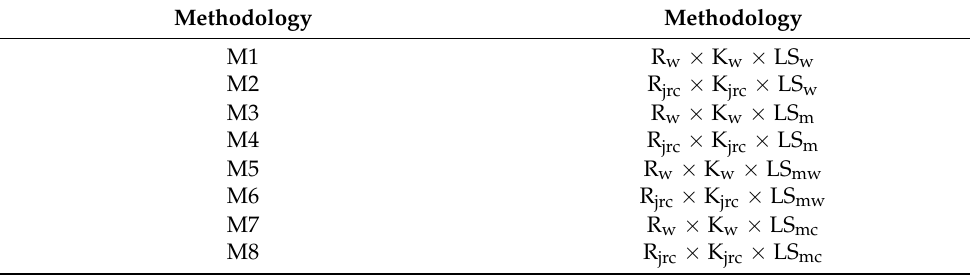
Table 2. Eight methodologies tested considering the different